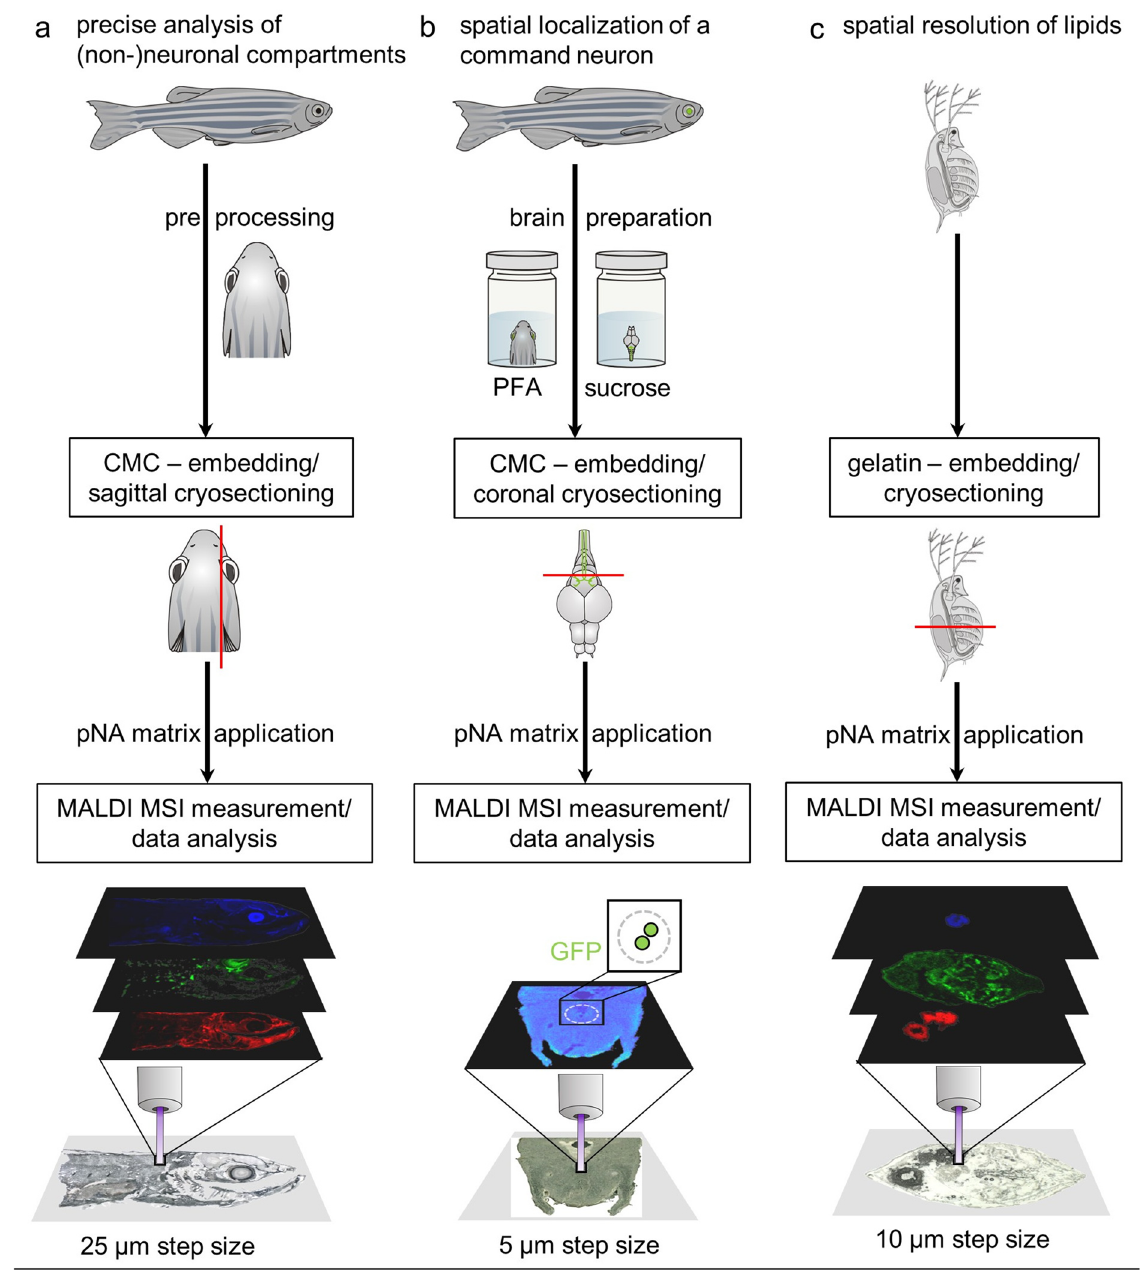
Figure 1. MALDI MSI workflow in D. rerio and D. magna . ( a ) Workflow for the precise analysis of lipid patterns visualizing anatomical features within neuronal and non-neuronal compartments. For sample preprocessing the adult zebrafish was cut cranial to the anal fin. The prepared sample was embedded in carboxymethylcellulose (CMC) and sagittal cryosections were prepared as indicated by the yellow line. Sections were covered with 4-Nitroaniline (pNA) matrix and MALDI MSI experiments were carried out in positive ion mode with 25 µm step size. ( b ) Workflow for the spatial localization of a command neuron in brain sections. Adult zebrafish were cut cranial to the anal fin and fixated in paraformaldehyde (PFA). After removal of the brain, it was fixated in sucrose and subsequently was embedded in CMC. Coronal cryosections were prepared as indicated by the red line. Brain sections (70 µm) were coated with pNA matrix and MALDI MSI measurements were carried out in positive ion mode with 5 µm step size. Prior to matrix application the sections were investigated by fluorescence microscopy to ensure the presence of the soma of the command neuron. ( c ) Workflow revealing the spatial distribution of lipids in whole body sections of D. magna . The sample was directly embedded in gelatin solution (8%) and sections (of 18 µm thickness) were prepared and coated with pNA matrix. MALDI MSI experiments (10 µm step size) were performed as described